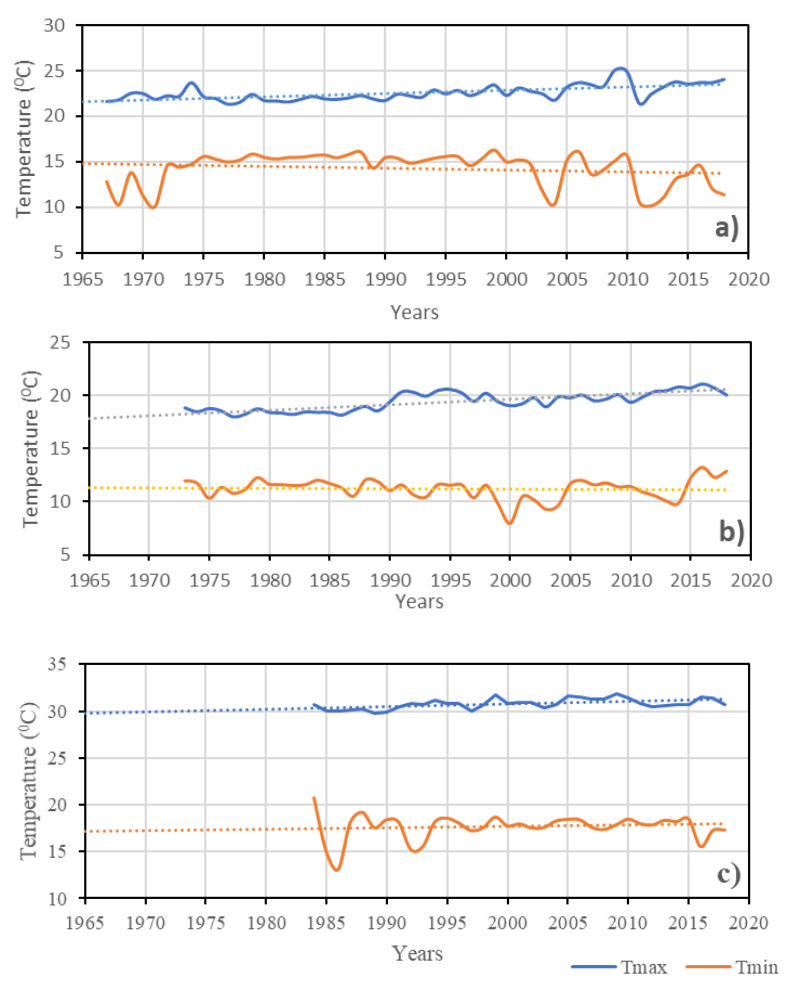
Figure 3. Average annual maximum and minimum temperature for stations ( a ) 1407, ( b ) 1416, and ( c ) 1421. The dotted line shows the trend by linear regression